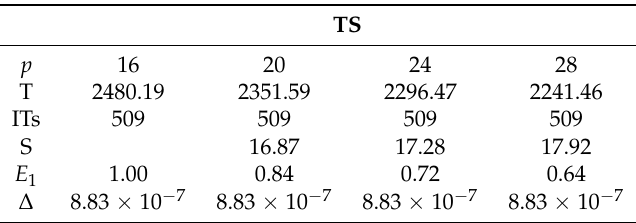
Table 7. Numerical results of Example